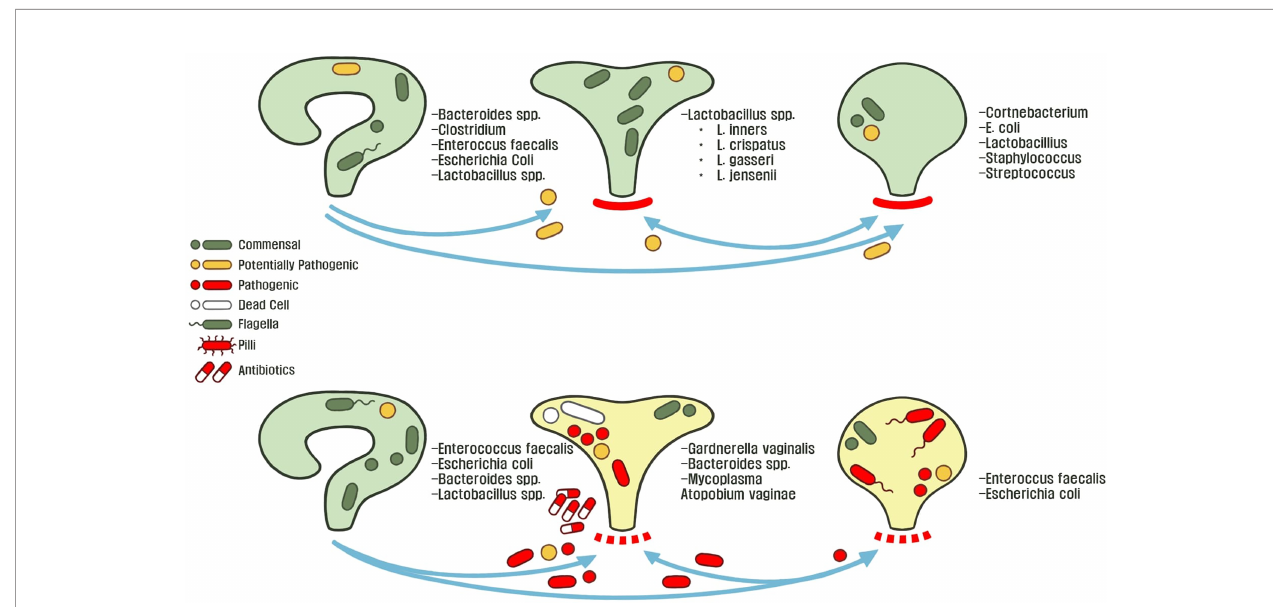
FIGURE 2 | The healthy or asymptomatic gut, vagina, and bladder microbiome is stable across individuals conditions. These microbiota protect their host- associated niche from foreign pathogens by controlling abiotic factors and outcompeting potentially invasive microbiota. Microbial dysbiosis and an adverse environment disrupts host homeostasis through various mechanisms such as: poor hygiene, metabolic changes (menopause, metabolic diseases, etc.), exposure to environmental metals or antibiotics, and consumption of food-borne pathogens. This allows for microbiota to transit between the perianal-urogenital pathway and in turn shapes other microbial communities towards dysbiosis and predisposes individuals to UTI